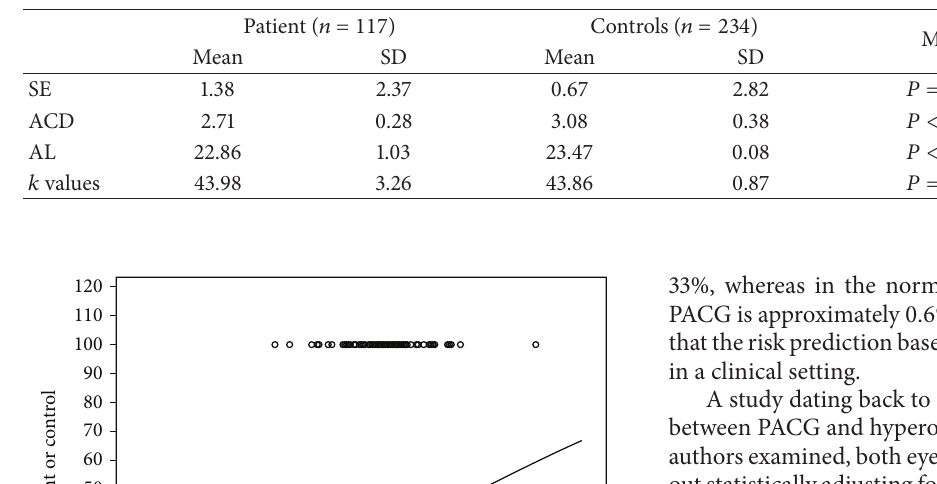
Table 3: Mean and standard deviation (SD) of the variables refractive error spherical equivalent (SE) in dioptres (D), anterior chamber depth (ACD) in millimetres (mm), axial length (AL) in mm, and mean of 𝑘 values in diopters. Differences were tested with the Mann-Whitney 𝑈 test (MWU). Results 𝑃 < 0.05 were assumed to be significant.